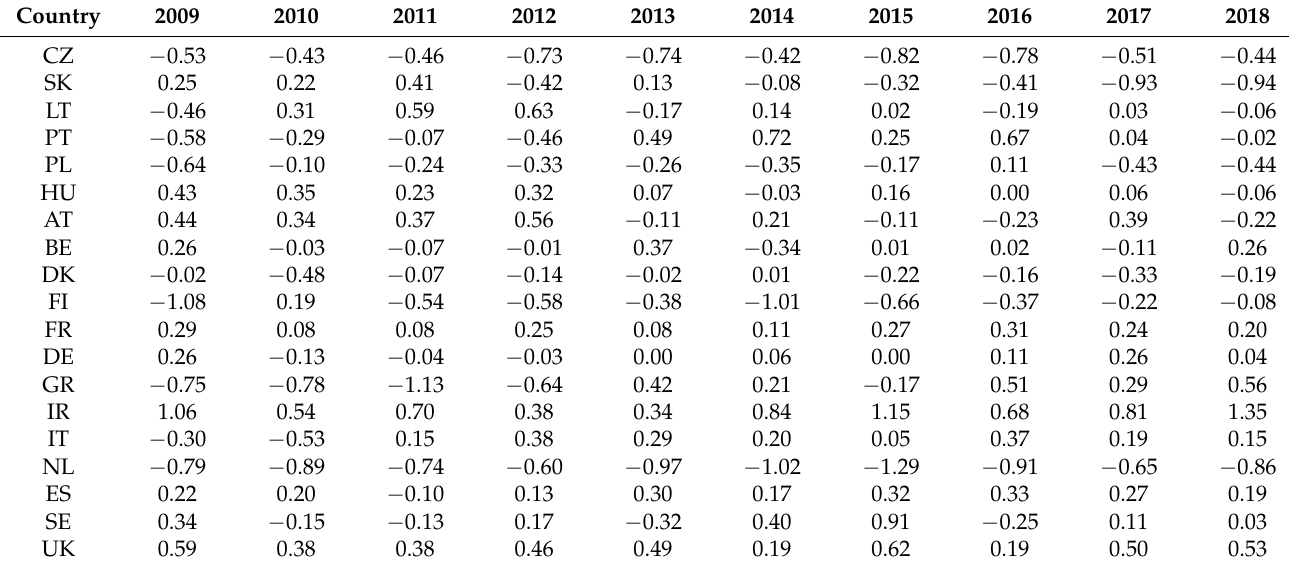
Table 4. EU chemicals and chemical products industry (ISIC 20–21) competitiveness measure index, 2009–2018. Source: own processing.